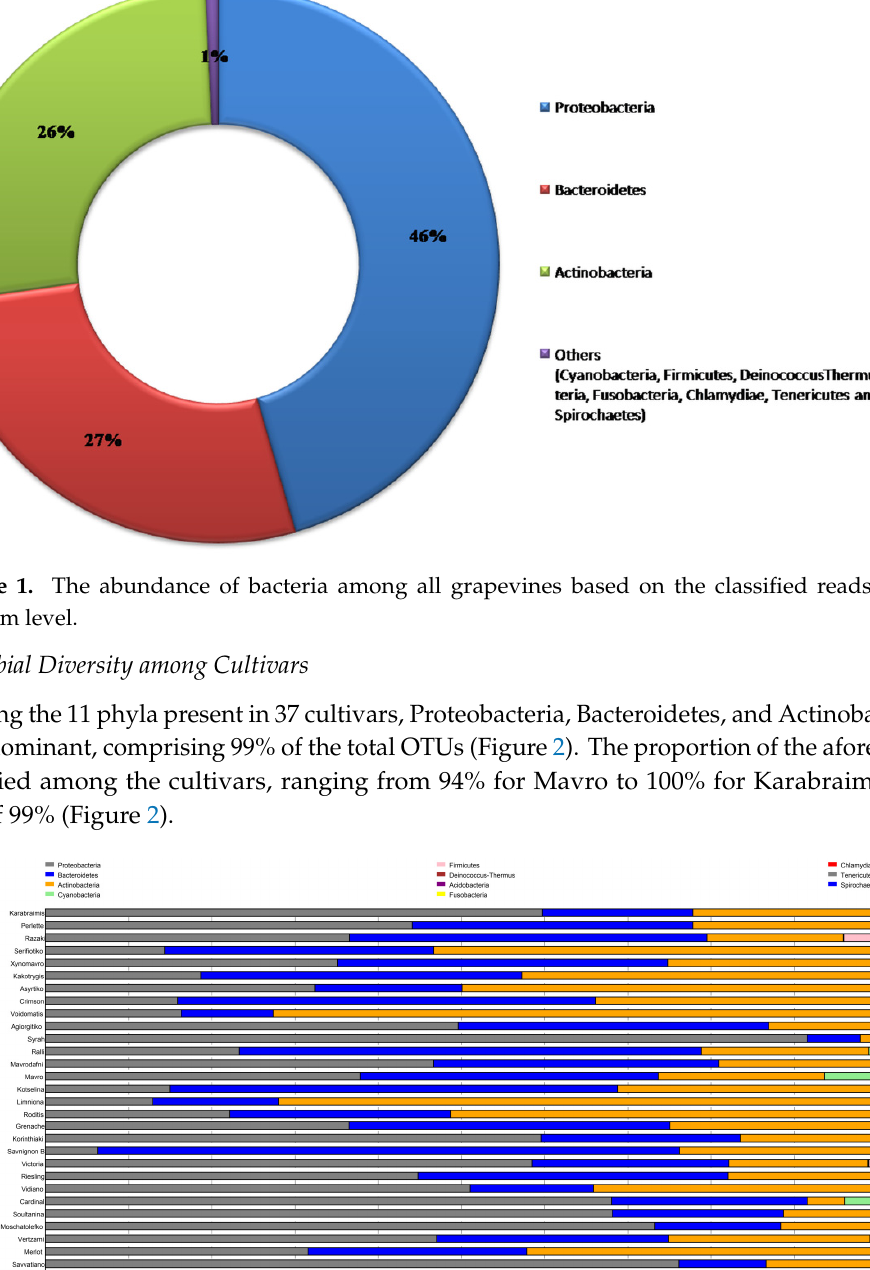
Figure 2. Relative abundance of the 11bacterial phyla of each grapevine based on the classified reads 5